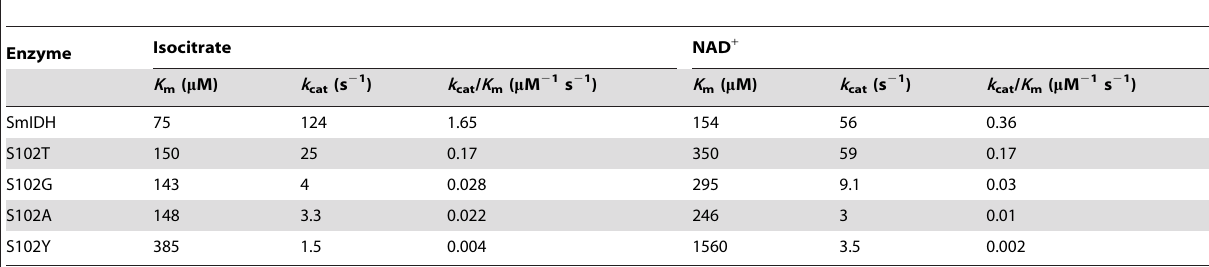
Table 3. Kinetic parameters of SmIDH and its mutants for isocitrate and NAD + .